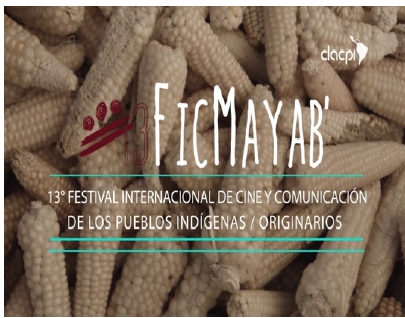
Figure 2. Indigenous Native Peoples International Festival of Cinematography and Communication. Source: www.clacpi.org, accessed on 11 September 2021.